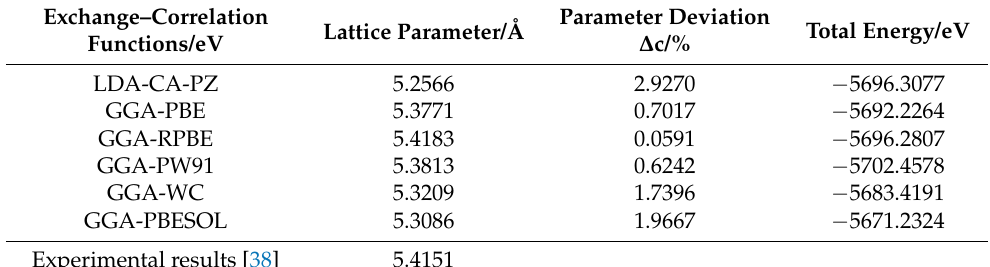
Table 1. Exchange–Correlation Functions convergence test results for cubic